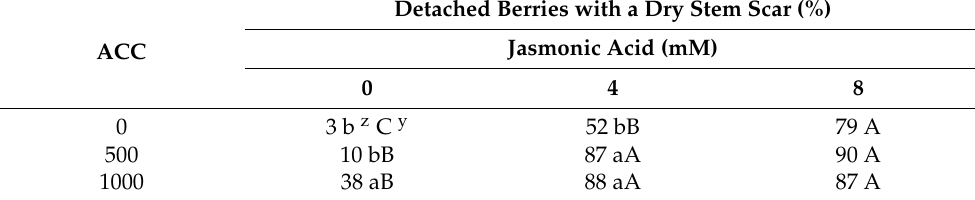
Table 4. The percentage of grapes with a dry stem scar after detachment. Measurements were made3